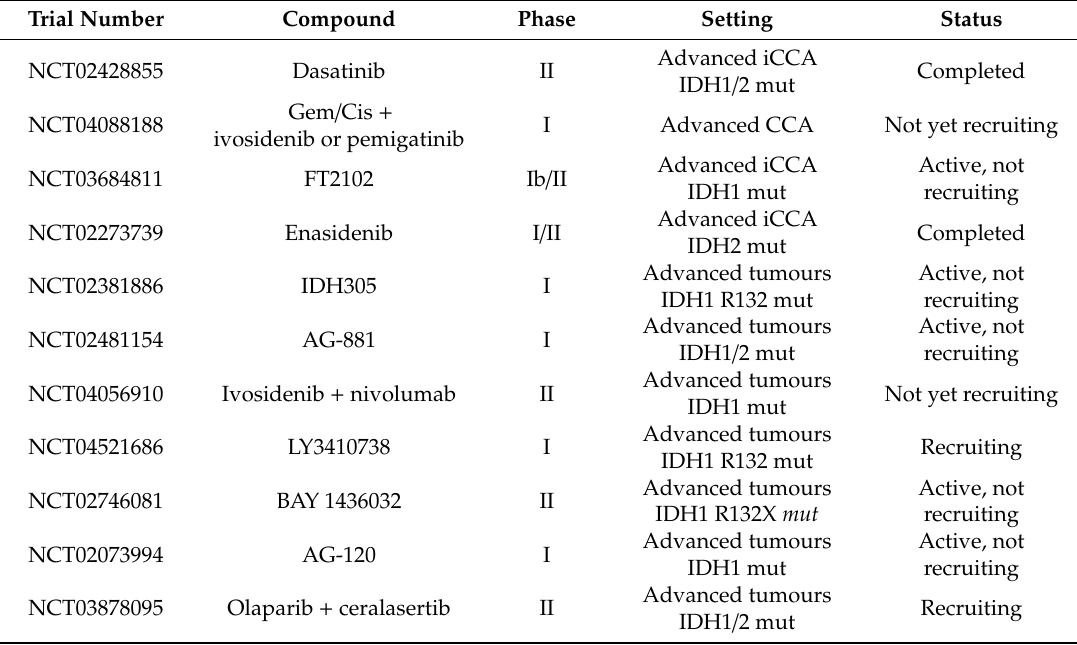
Table 1. Selected clinical trials of IDH1 / 2 inhibitors in advanced cancers including